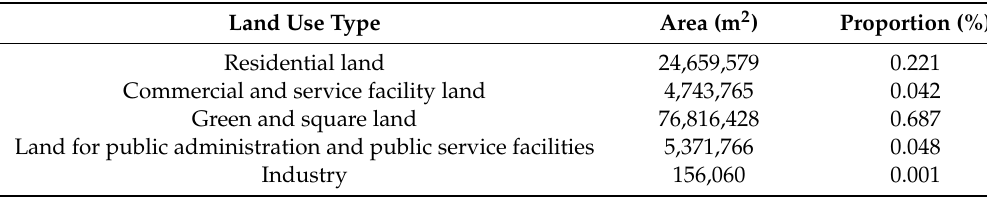
Table 4. Proportion of di ff erent land use